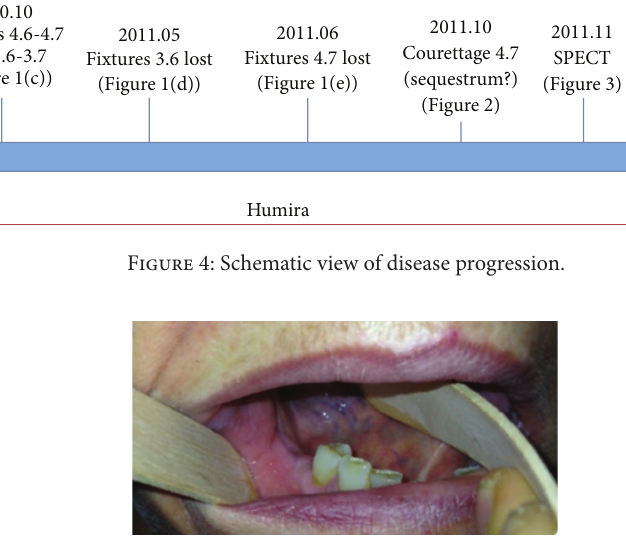
Figure 5: Postoperative control in 2015 showing the healing of the mucosa after extraction of tooth 4.5 and curettage of the bone.